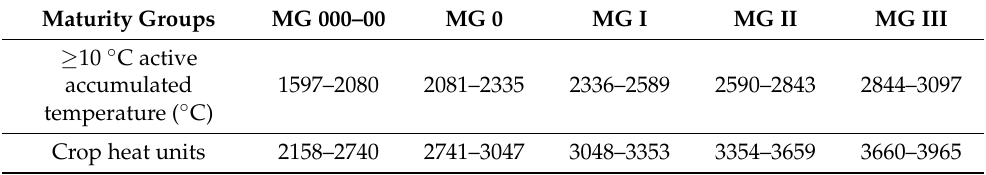
Table 1. ≥ 10 ◦ C active accumulated temperature and crop heat units in different maturity